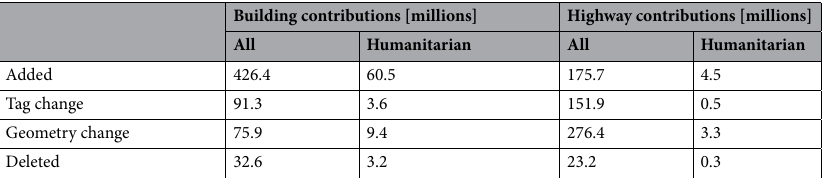
Table 1. Cumulative number of added, changed and deleted buildings and highways in OSM between 2008/01/01 and 2020/05/20 in regard to overall and humanitarian mapping